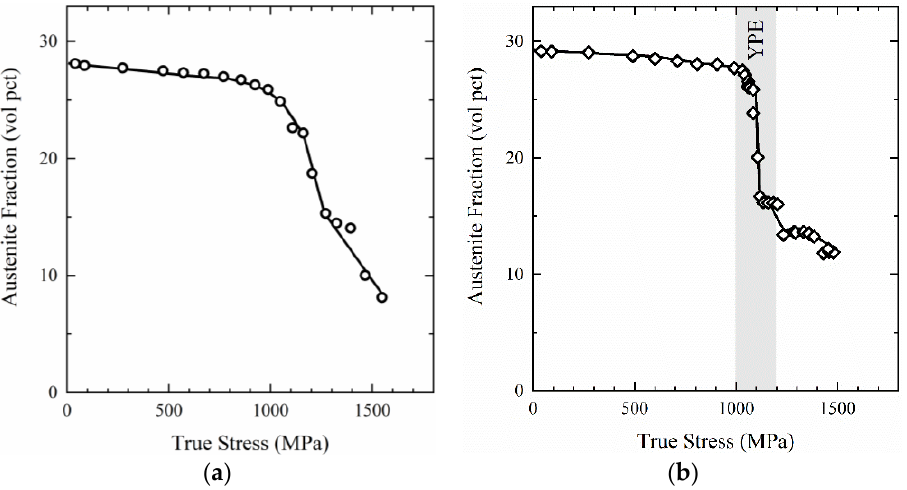
Figure 5. Austenite volume fractions as a function of macroscopic true stress for the ( a ) double soaked (DS) and ( b ) double soaked and tempered (DS-T) heat treatment conditions.